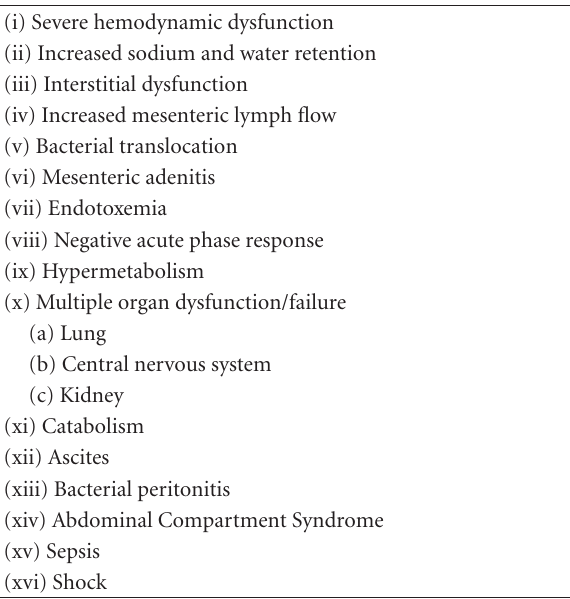
Table 4: Characteristics of the experimental cholestatic portal hypertensive syndrome.